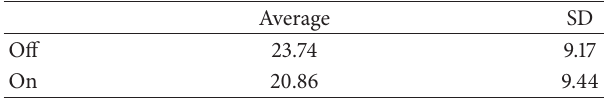
Table 2: The mean and standard deviation (SD) of the SYNERGOS index during off- and on-medication